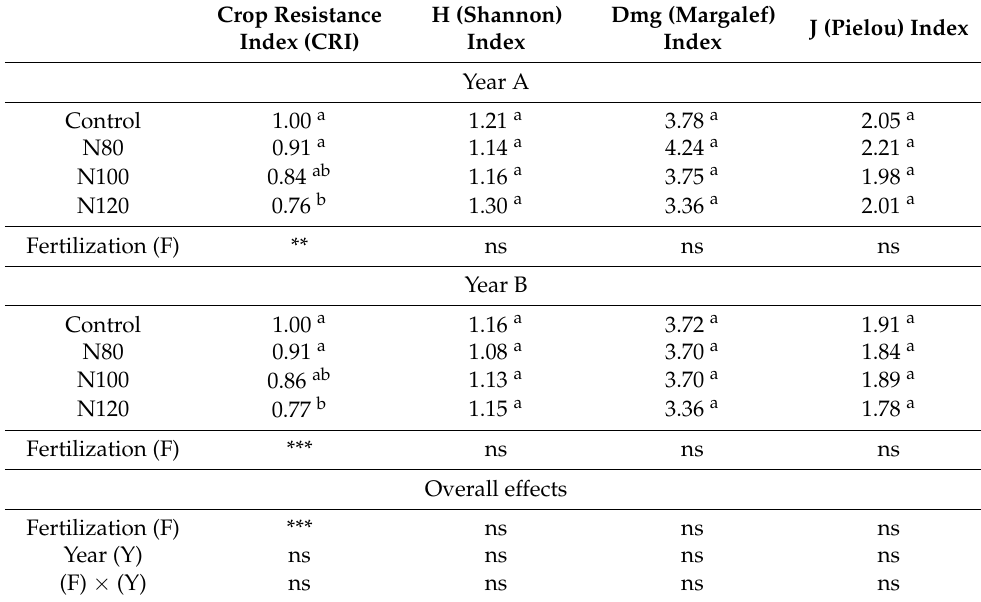
Table 5. Weed indices as affected by the different N fertilization rates.